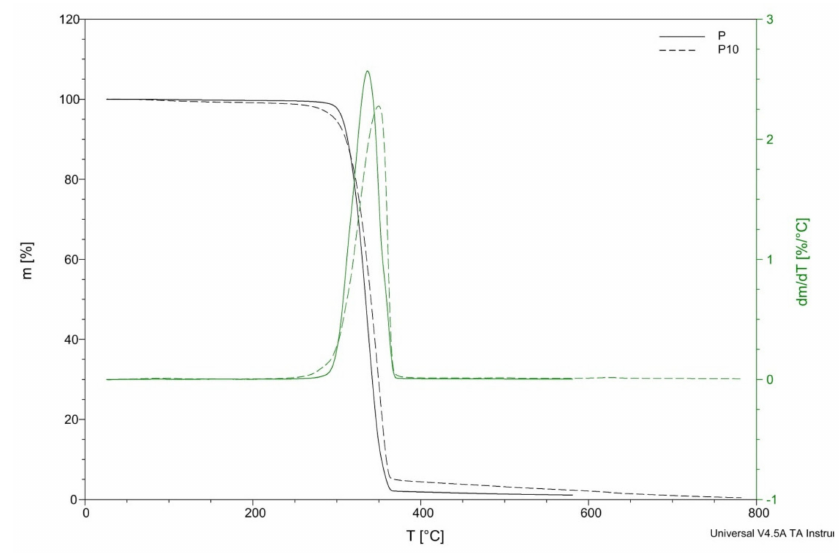
Figure 8. Thermogravimetry (TG) curves for samples P and